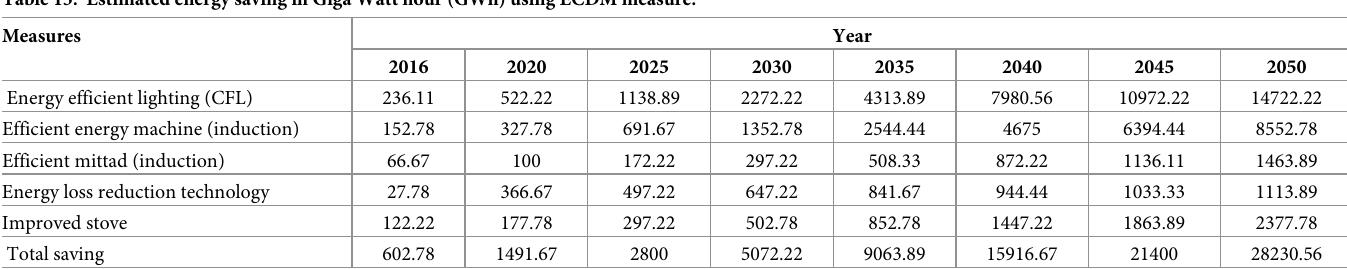
Table 13. Estimated energy saving in Giga Watt hour (GWh) using ECDM measure.